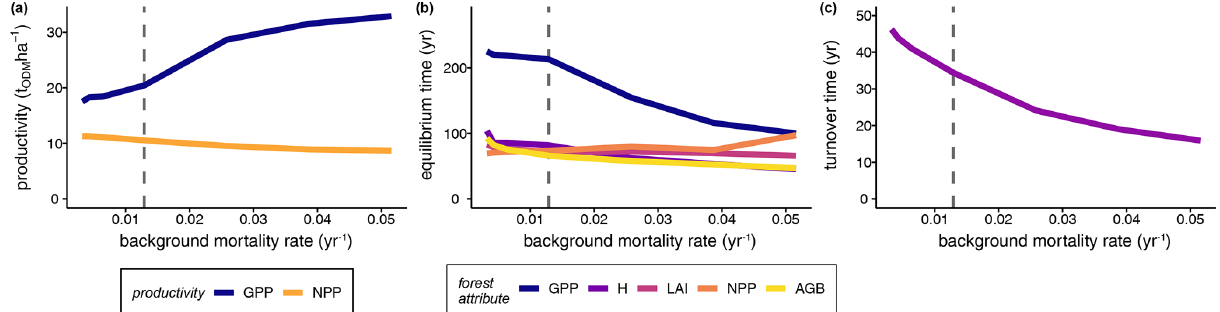
Figure 4. Influence of different mortality levels in simulated terra firme forests on (a) mature forests’ mean GPP and mean NPP (averages over simulation years 250–300), (b) the time until the forest attributes reached equilibrium states, and (c) the mean biomass turnover times, represented as the reciprocal values of the biomass loss rate (see Eq. 5; averages over years 0–300). Dashed lines indicate the baseline scenario (GPP: gross primary production, NPP: net primary production, H : forest height, LAI: leaf area index, AGB: aboveground biomass, ODM: organic dry